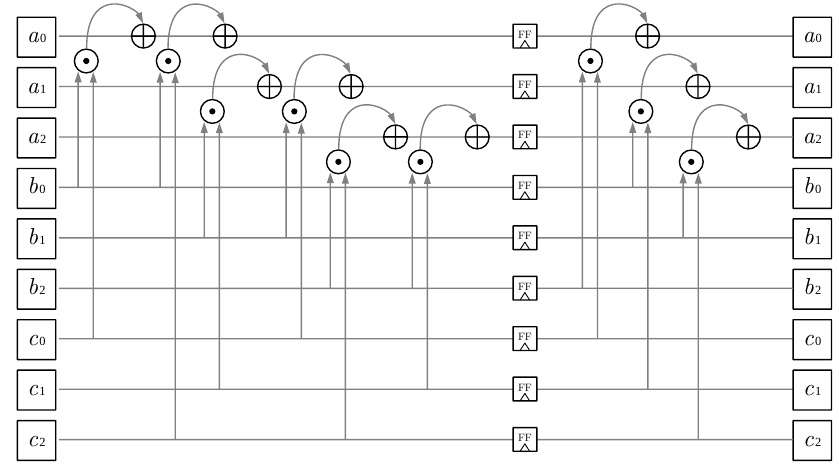
Figure 8: 3-share TI and single-fault SIFA-protected Toffoli gate in